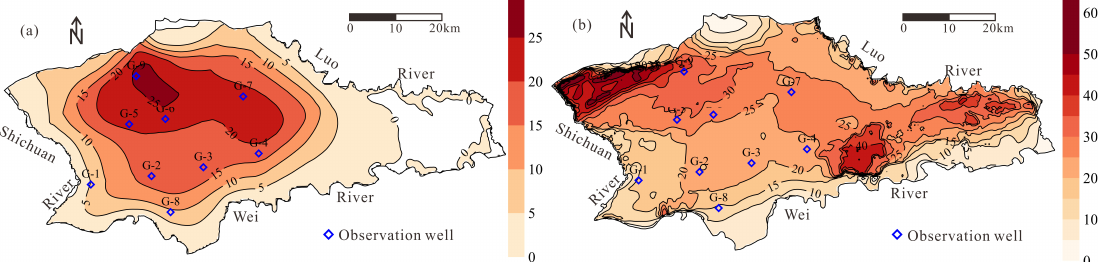
Figure 7. Maps that show the ( a ) decrease in water level and ( b ) buried depth after 50 years for scenario 1.